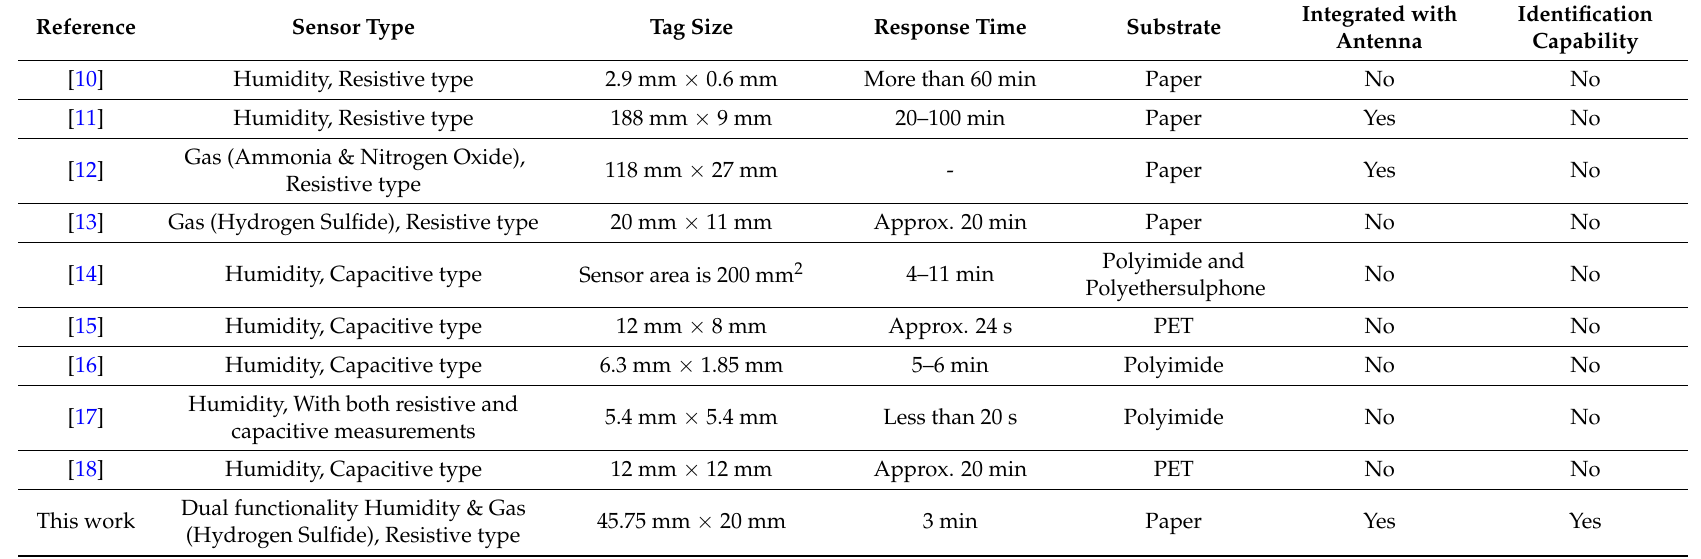
Table 3. Comparison with published